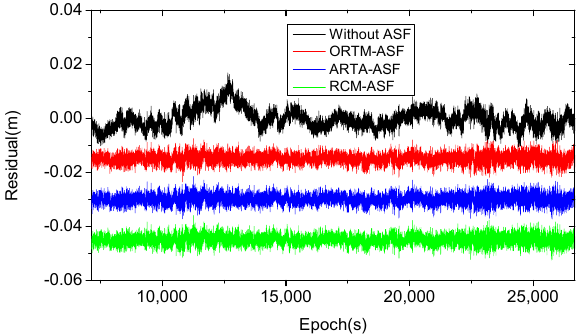
Figure 9. Residual time series of single-differenced observables for PRN 13 on DOY 344, 2014. For comparison, time series of “ORTM-ASF”, “ARTA-ASF”, and “RCM-ASF” are shifted by − 1.5, − 3, and − 4.5 cm, respectively. Table 3. RMS of residual time series for PRN 13.